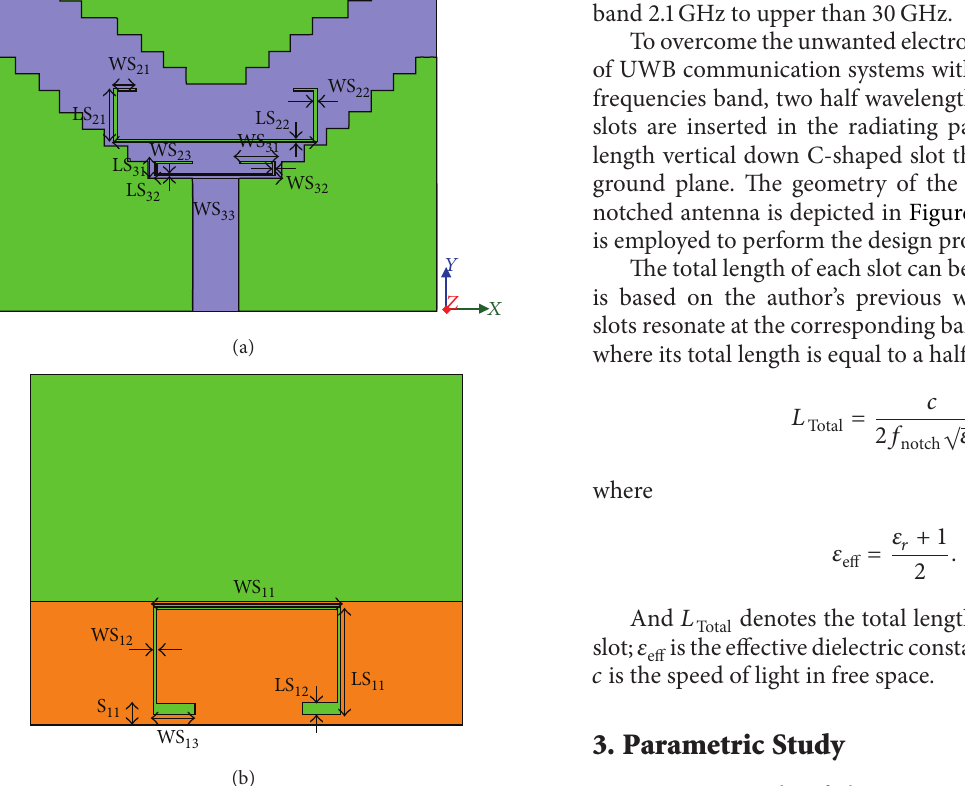
Figure 3: The geometry of the proposed triple band-notched antenna: (a) top view and (b) bottom view.